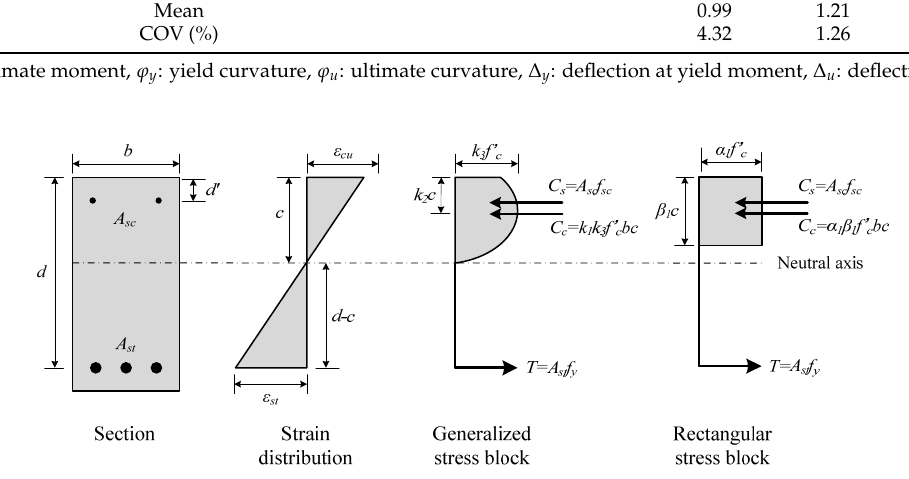
Figure 6. Stress distribution in the cross ‐ section at ultimate.